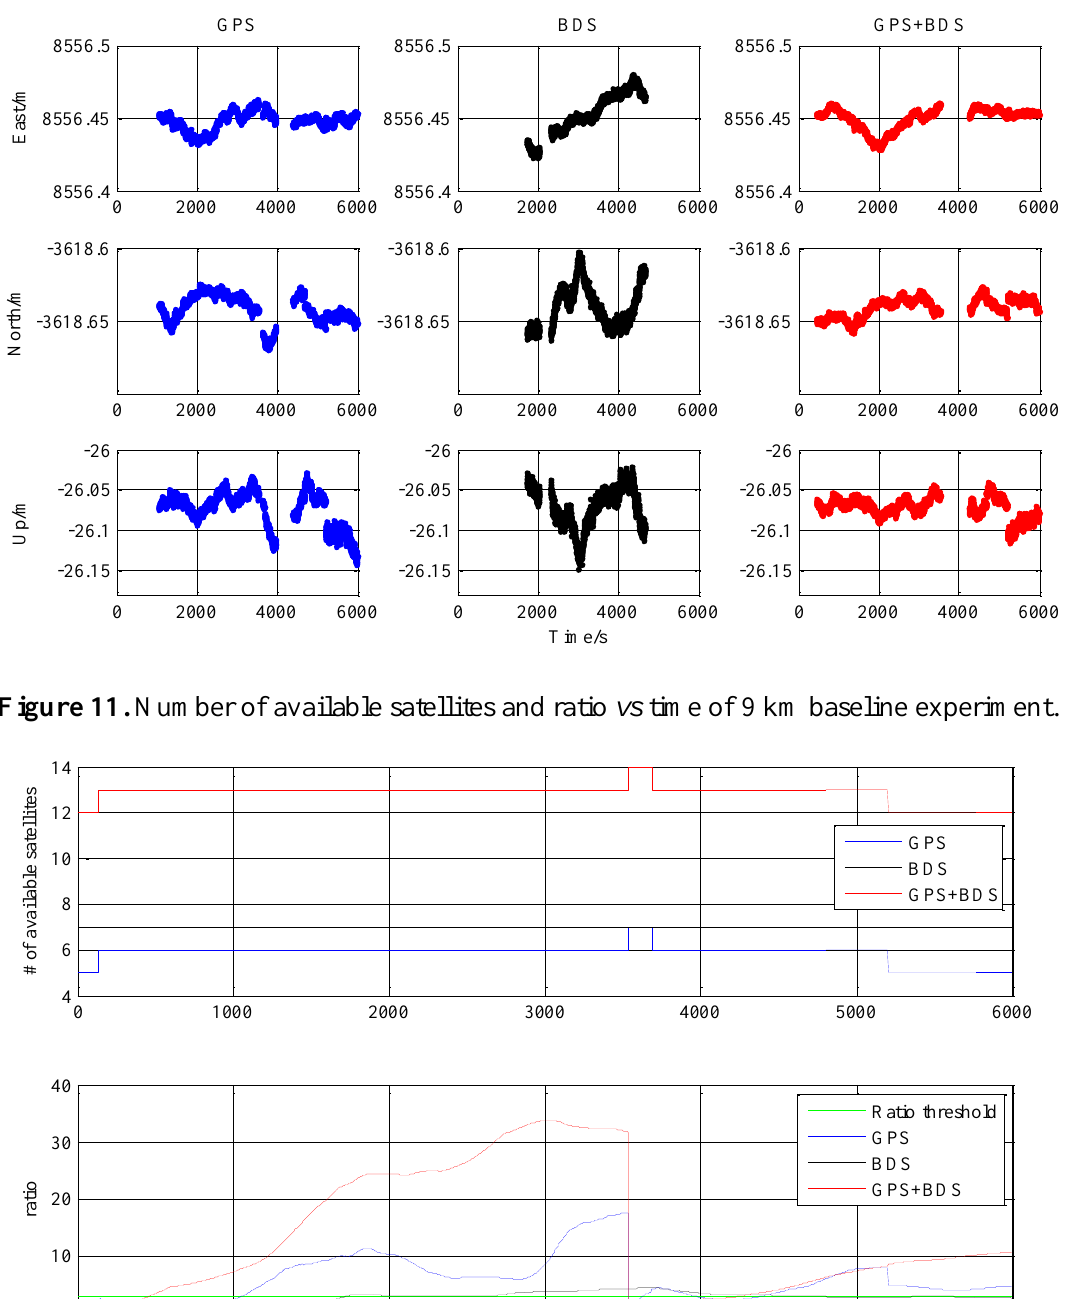
Figure 10. ENU baseline result of 9 km baseline experiment (fixed epochs, ratio > 3).